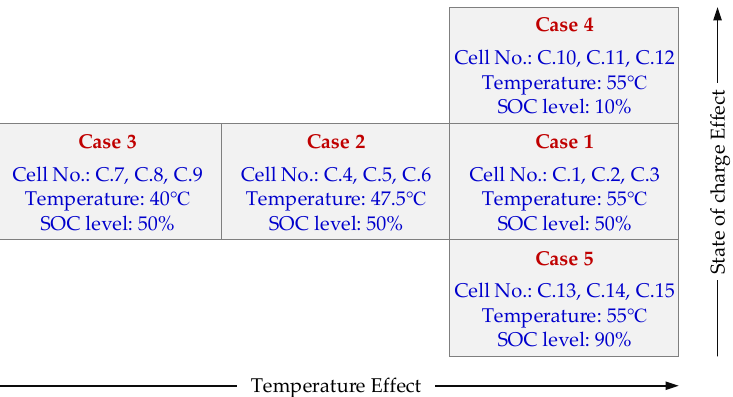
Figure 1. The test matrix for determining the calendar lifetime of the LiFePO 4 / C battery cells (possible interaction between stress factors is not considered.